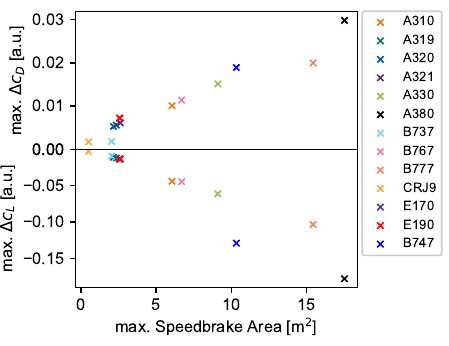
Figure 4. Change in lift coefficient ∆ c L , i (blue) and drag coefficient ∆ c D , i (orange) for different speed brake angles of an Airbus A310 aircraft. A clean flap configuration, a Mach number of 0.82, an angle of attack of α = 0 ◦ , and an altitude of 30,000 ft are assumed. A310 speed brakes are numbered from inside to outside (scatter markers).